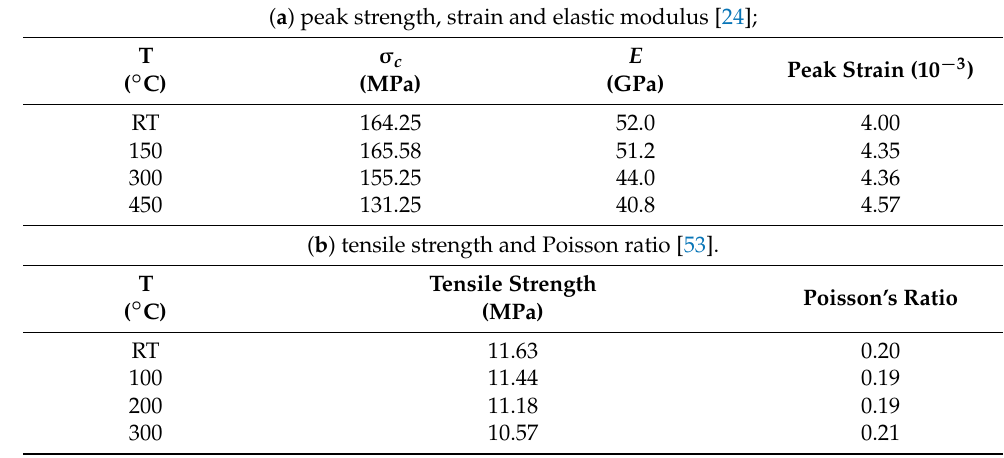
Table 1. Some key temperature-dependent mechanical properties of Fujian